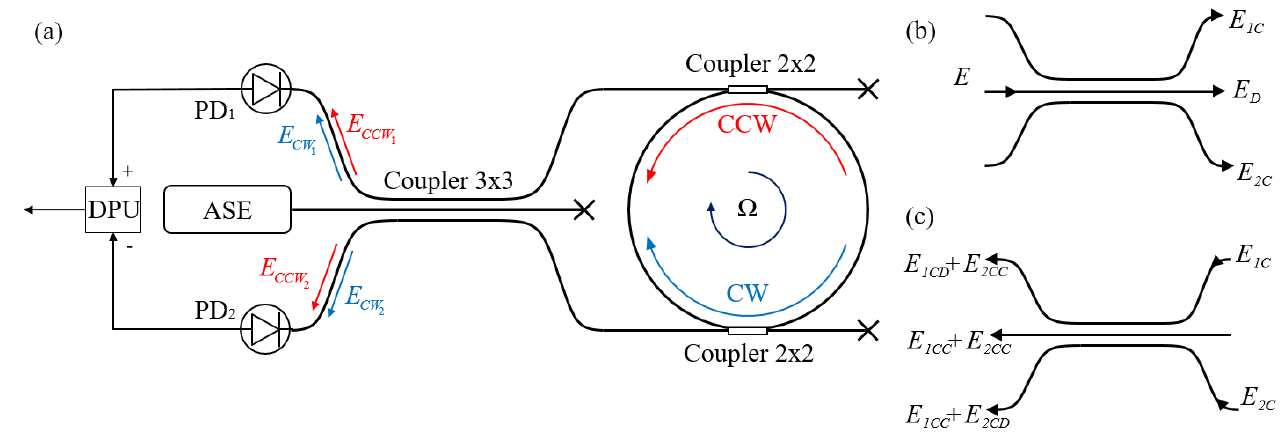
Figure 2. ( a ) The schematic diagram of the passive resonant fiber optic gyroscope with a 3 × 3 direc- tional coupler. ASE—spontaneous emission amplifier; PD 1 and PD 2 —photodetectors; DPU—signal- processing module, CW and CCW—irradiation passing through clockwise and counterclockwise, respectively (the rotation axis is normal to the picture plane; the rotation direction is clockwise); ( b ) the scheme of the radiation passage through the directional couple from ASE to the resonator; and ( c ) the scheme of the radiation passage through the directional couple from the resonator to the photodetectors.